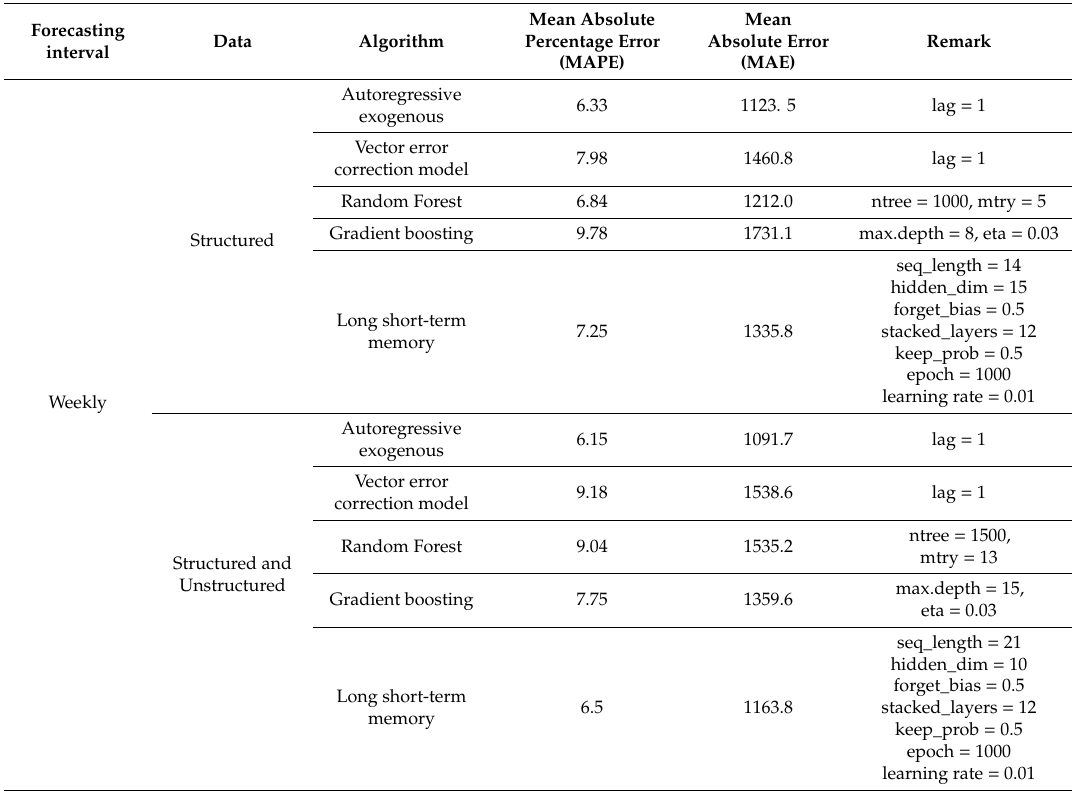
Table 5. Comparison of forecasted weekly amounts to purchase pork belly meat in